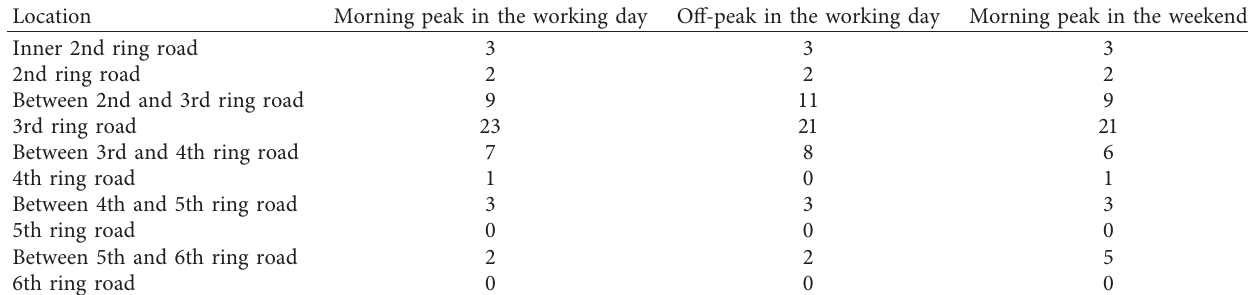
Figure 14: Key bus stations occupying top 50 in the morning peak (weekend). Table 3: The number distribution of key bus